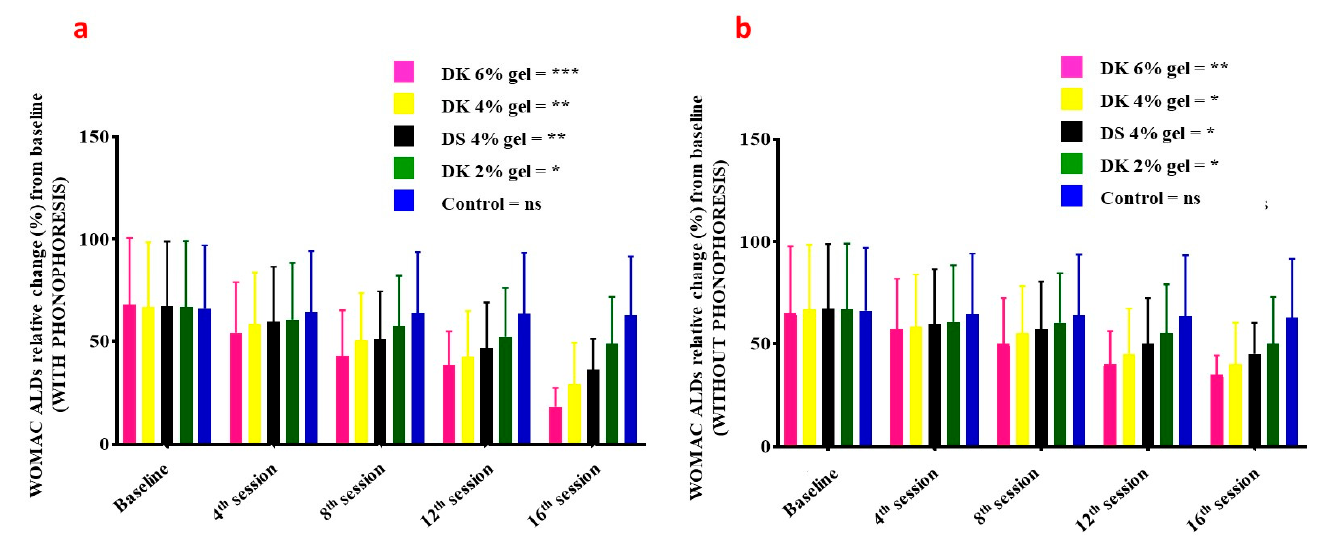
Figure 5. Index of WOMAC ADLs on the baseline, 4th session, 8th session, 12th session, and 16th session of Diclofenac potassium (DK) treatment ( a ) with phonophoresis ( b ) without phonophoresis, in sports-injured patients. Diclofenac sodium (DS) was used as a standard control. Control group is the placebo. Statistical significance ( p -values) is detailed in the main text. ns = no significant; p < 0.05 *, p < 0.01 **, p < 0.001 ***. WOMAC: Western Ontario and McMaster Universities Arthritis Index, ADLs: activities of daily